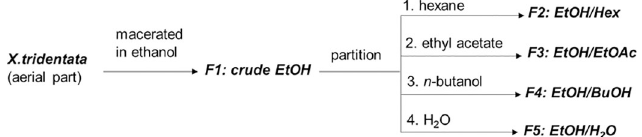
Scheme 1 . Preparation of the crude extract and sub-partitions from X . tridentata .